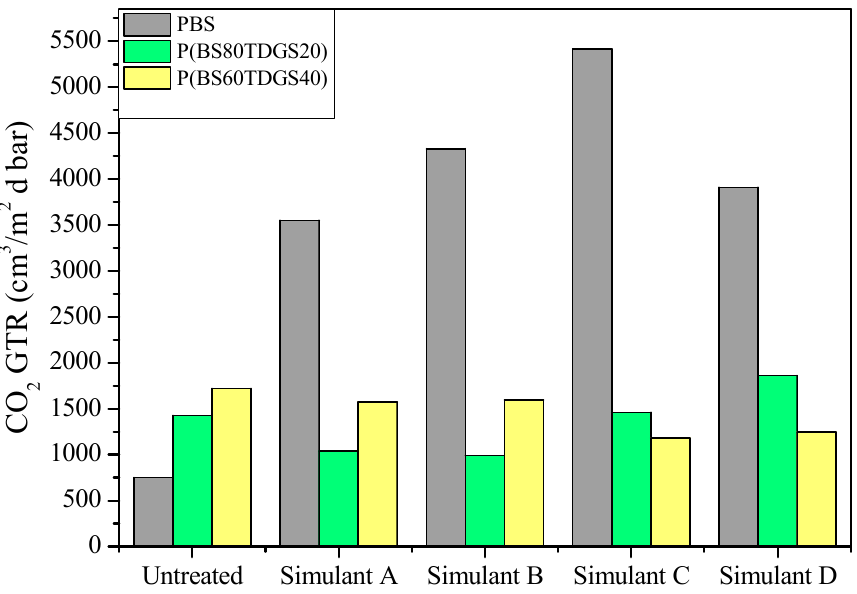
Untreated Simulant A Simulant B Simulant C Simulant Figure 1. CO 2 GTR after food simulant contact for PBS and P(BSxTDGSy) copolymers. Figure 1. CO 2 GTR after food simulant contact for PBS and P(BSxTDGSy)